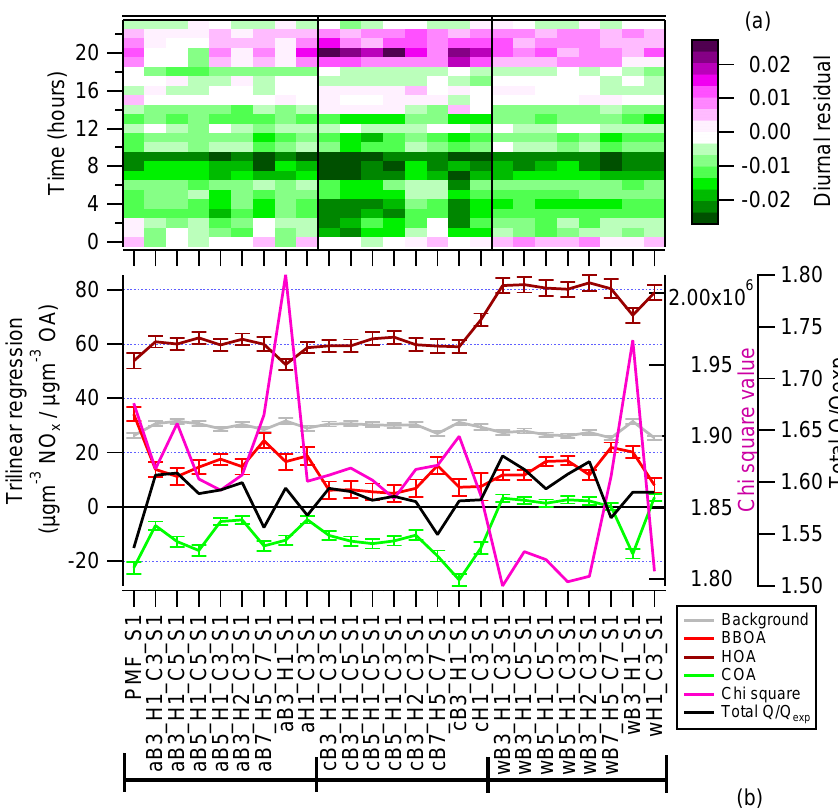
Figure 2. (a) Diurnal residual, y axis represents time up to 24h and x axis represents the different solutions with a variety of target profiles and a values. (b) NO x trilinear regression for solutions with different target profiles. BBOA represents the slope of µgm − 3 of NO x per µgm − 3 of BBOA. The same applies for HOA and COA. Whiskers represent the 95% confidence